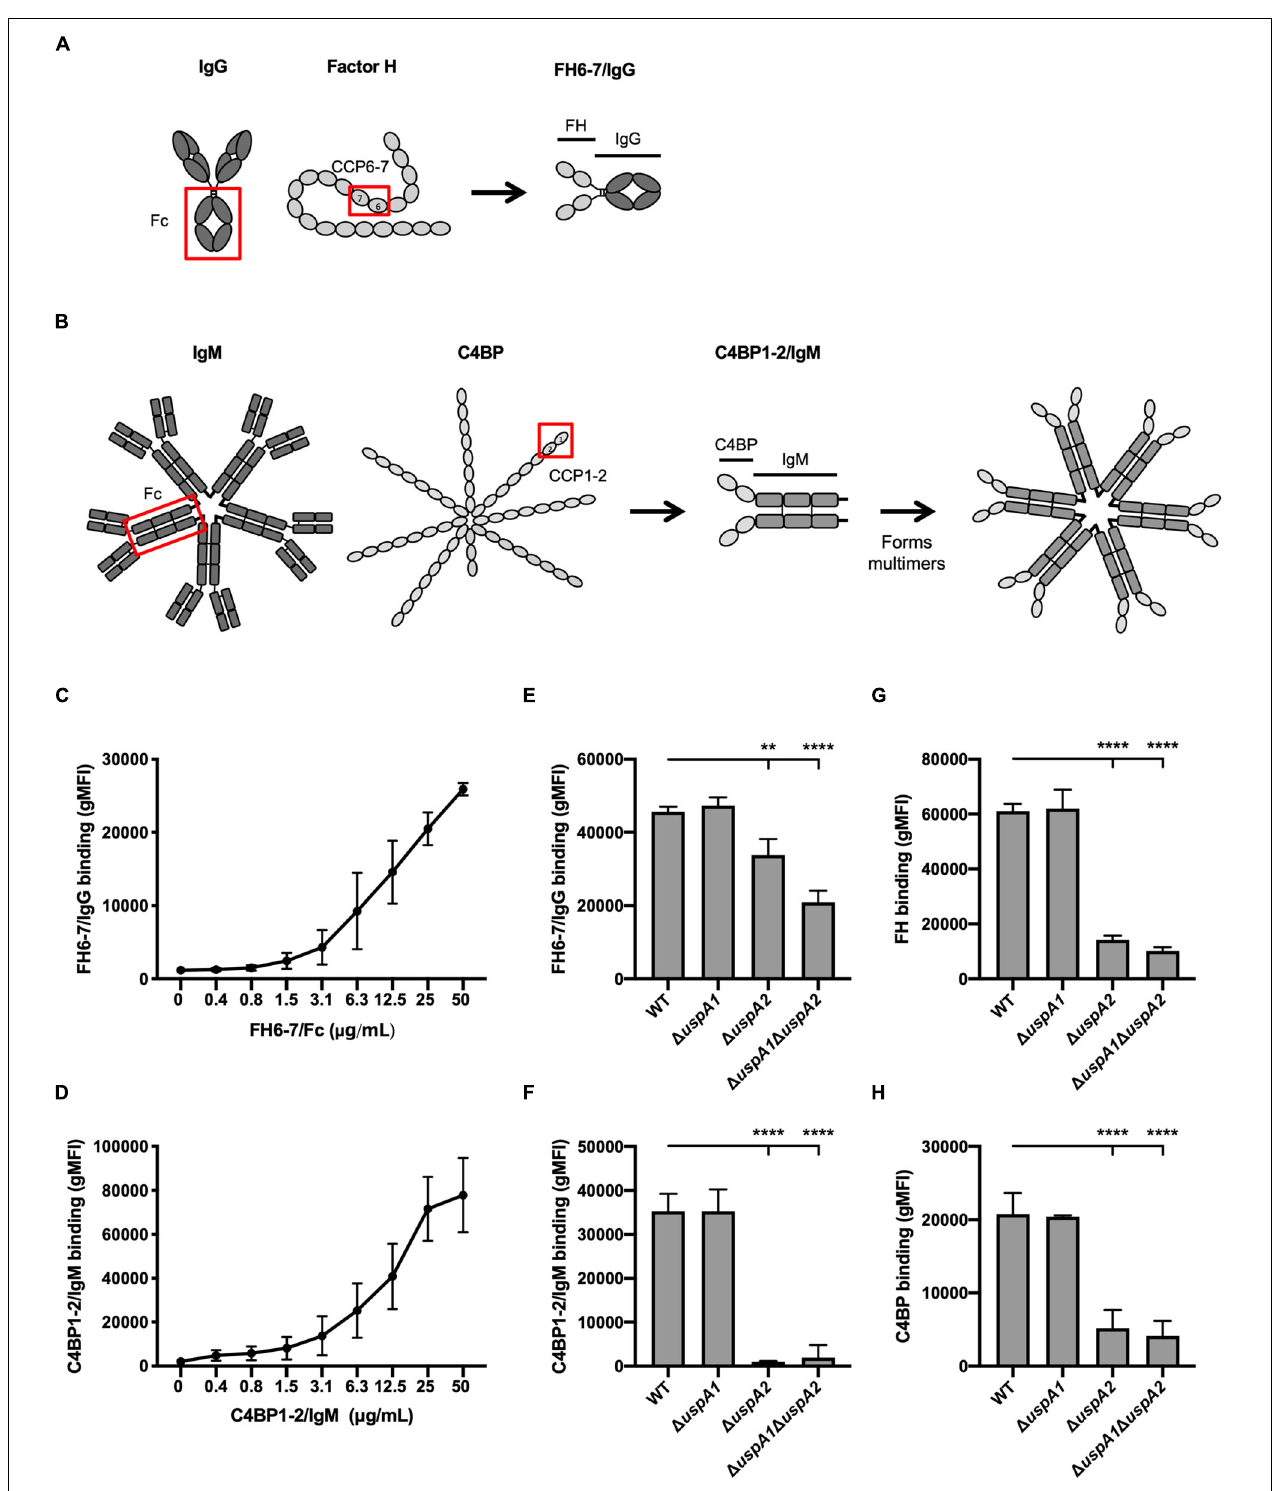
FIGURE 1 | FH 6-7/IgG and C4BP1-2/IgM bind to M. catarrhalis . (A,B) Schematic representation of fusion proteins FH6-7/IgG and C4BP1-2/IgM, respectively. (C) Binding of FH6-7/IgG and (D) C4BP1-2/IgM to M. catarrhalis RH4 [wild-type (WT) reference strain] assessed by flow cytometry. (E–H) Binding of RH4 WT and isogenic mutants lacking uspA1 and/or uspA2 to (E) FH6-7/IgG, (F) C4BP1-2/IgM, (G) factor H (FH), and (F) C4b-binding protein (C4BP). Mean ( ± SD) from three independent experiments are shown. Statistical significance of differences was calculated using one-way ANOVA with Dunnett’s post-test (E–H) ; ** p < 0.01 and **** p <